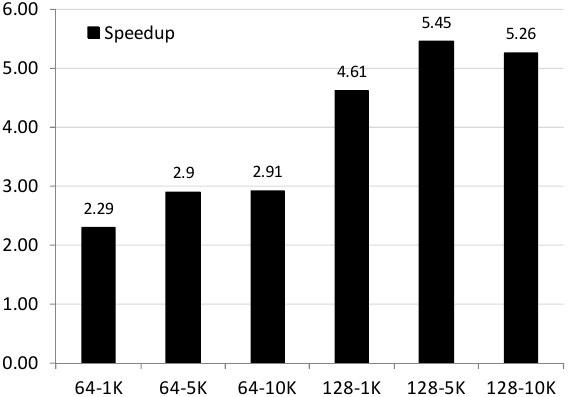
Figure 12. Speedup when comparing CPU and GPU times for Eil76 with respect to different popu- lations (64 and 128) and iterations (1000, 5000, and 10,000).